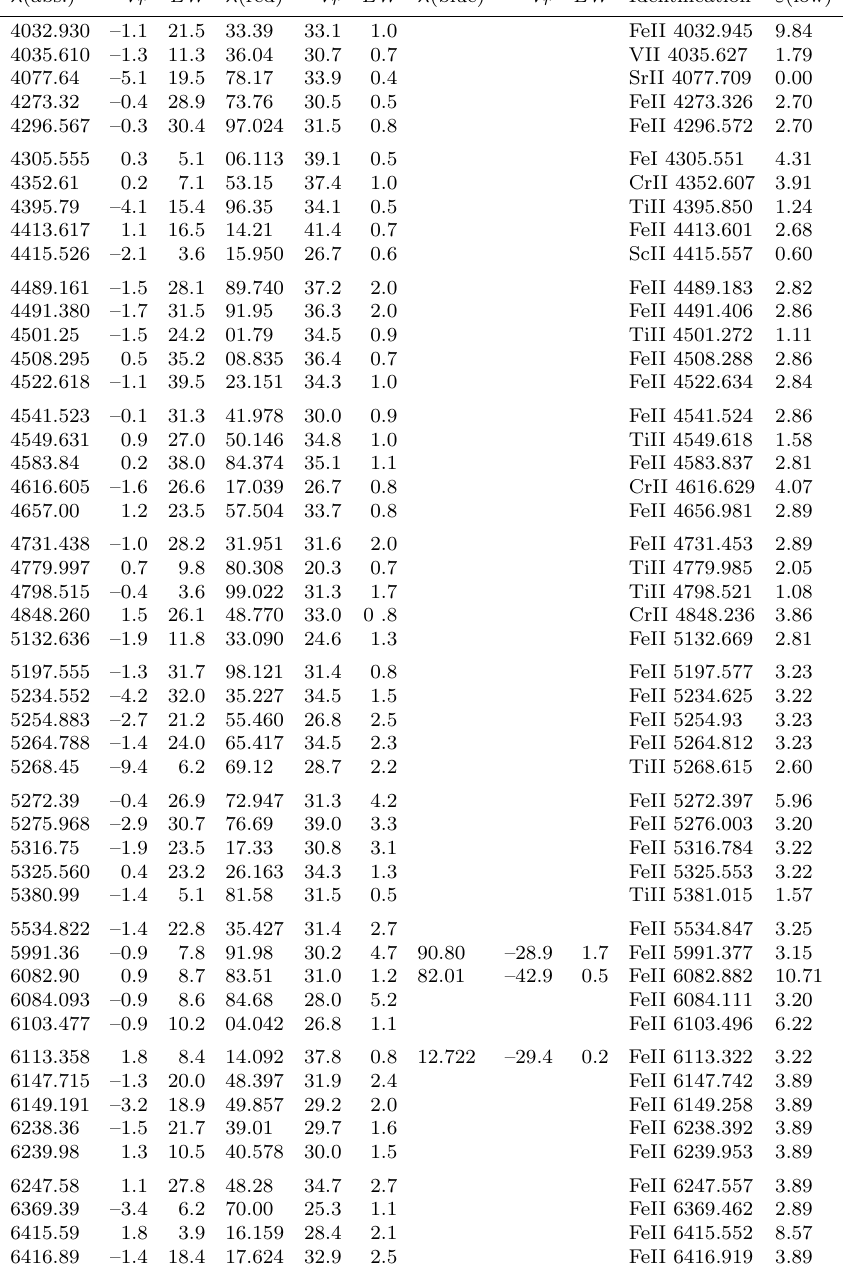
Table 4. The lines with P Cygni pro(cid:12)les in the spectrum of υ Sgr. The equivalent widths are given in picometers. λ